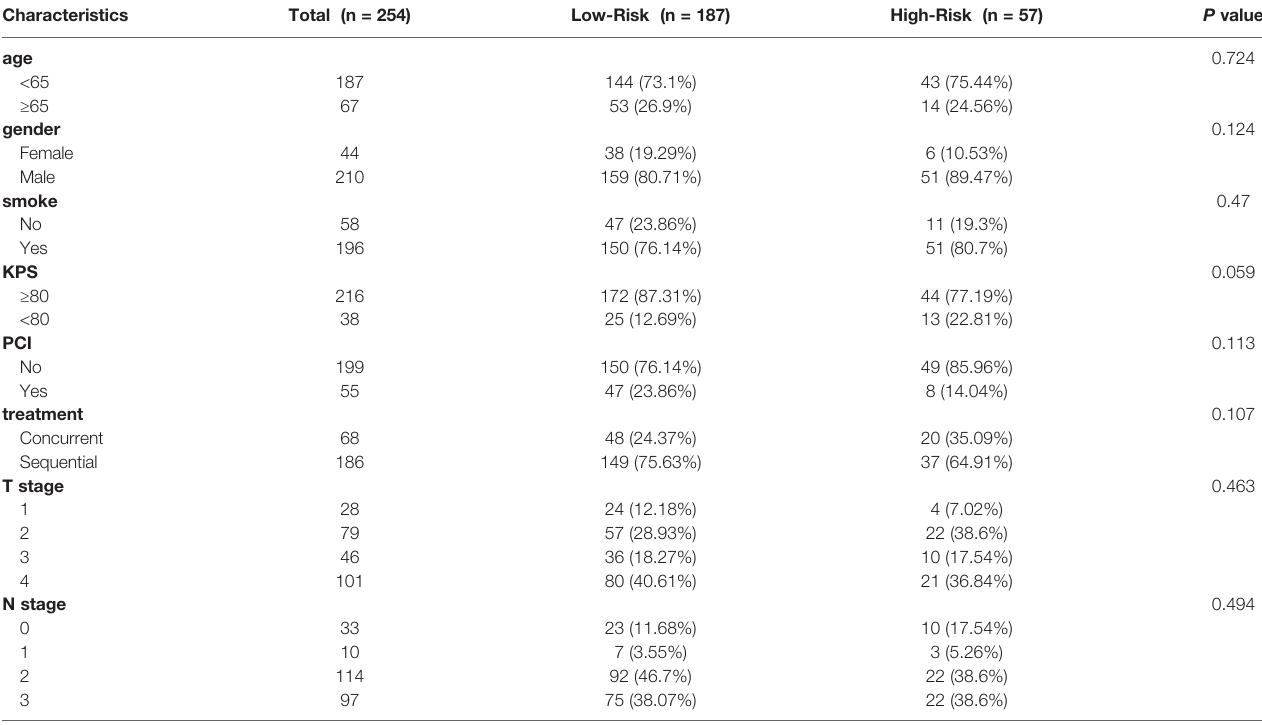
TABLE 4 | Baseline characteristics of low-risk group and high-risk group. Characteristics